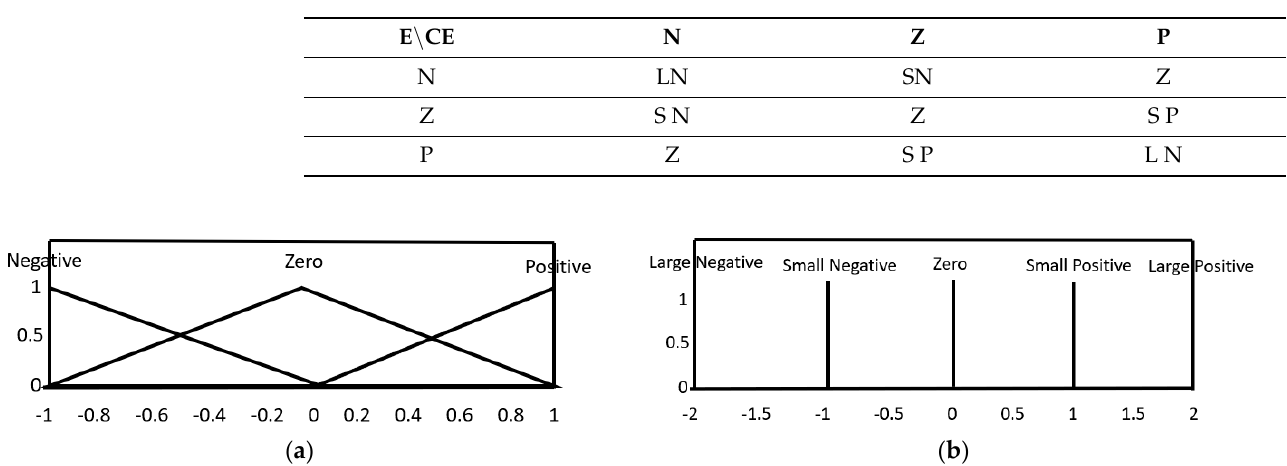
Table 3. Fuzzy rule base.